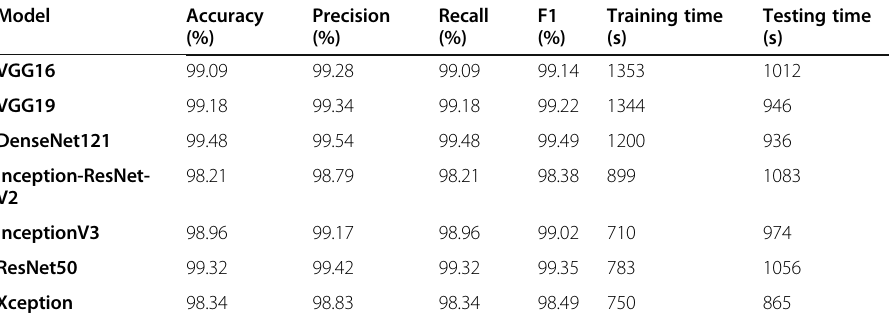
Table 5 Performance metrics